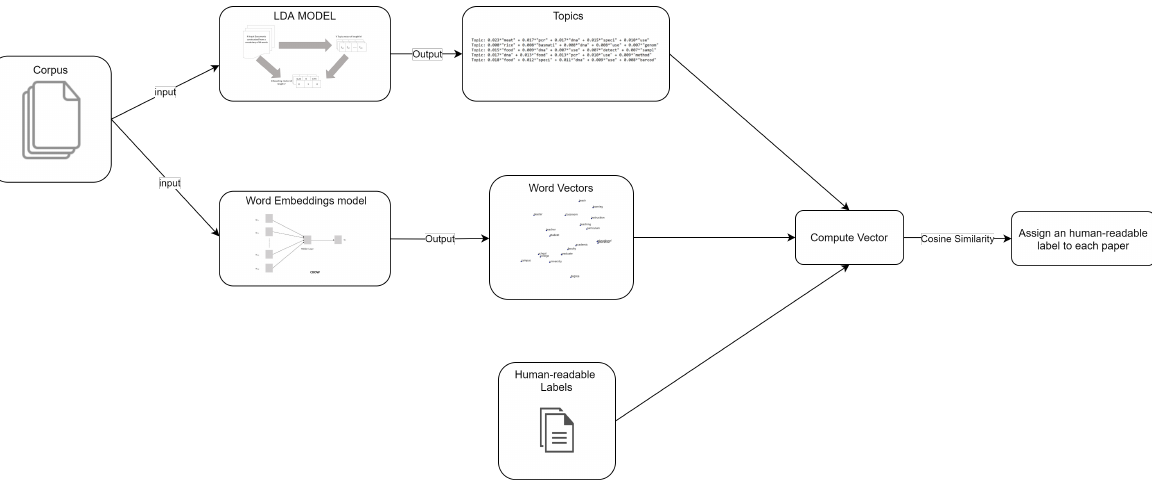
Figure 4. WORKFLOW of